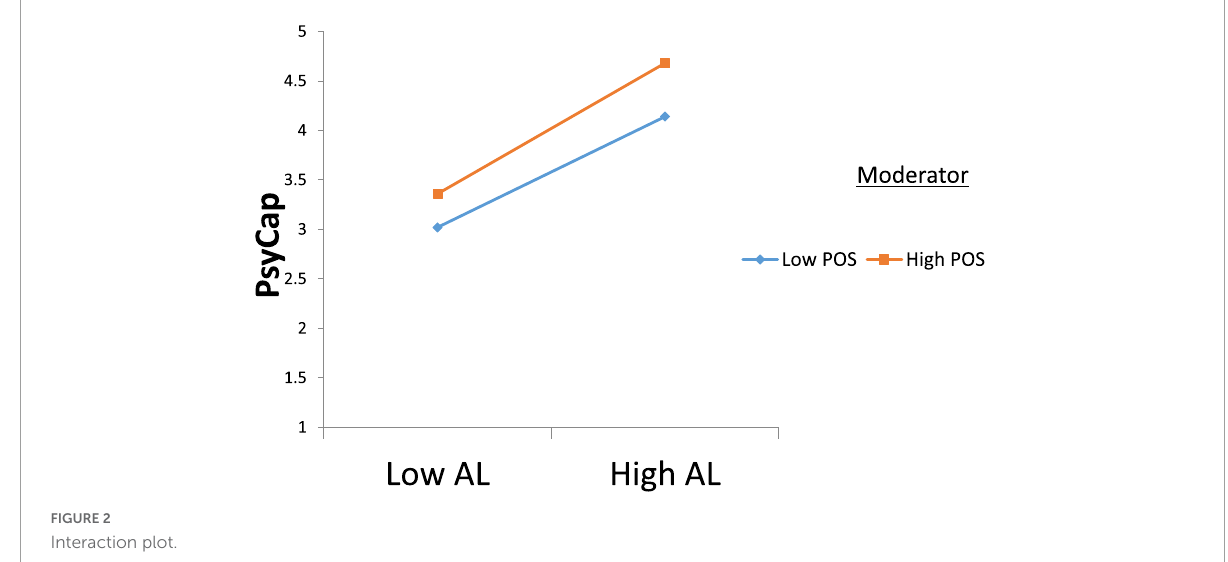
FIGURE2 Interaction